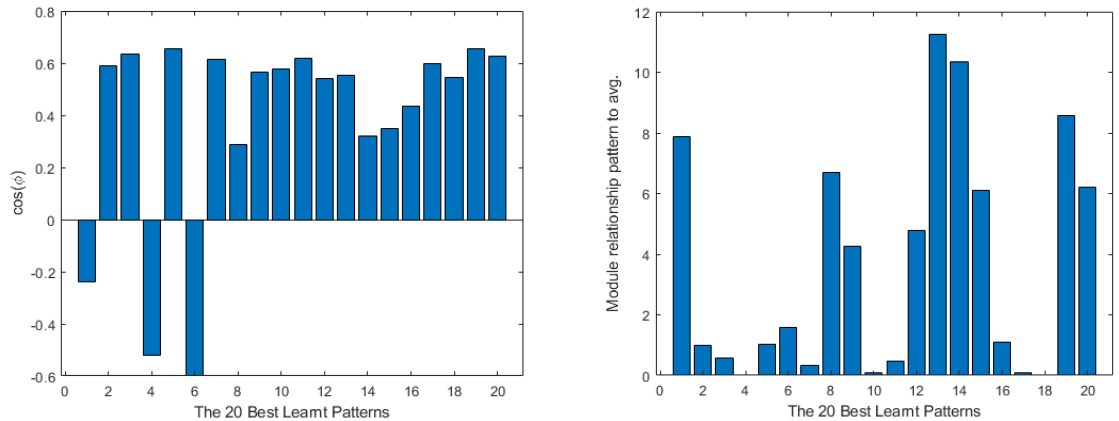
(cid:12) (cid:12) 𝜕𝐿𝑜𝑠𝑠 ∂ Loss (cid:12) (cid:12) | relationship to the average (cid:12) (cid:12) relationship to the average ∂ W n 𝜕𝑊 𝑛